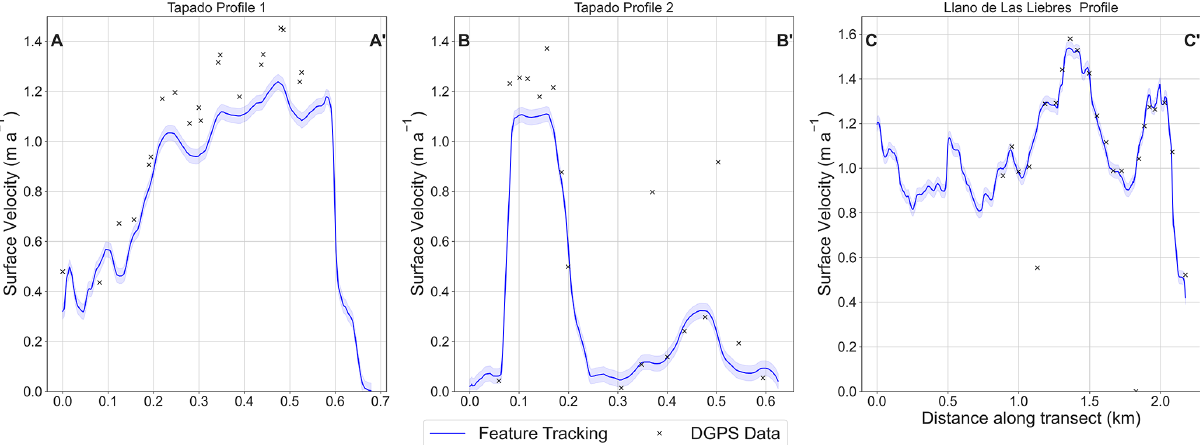
Figure 8. Comparison of optical-feature-tracking-based velocities and DGNSS-derived velocities along three profiles on the Tapado complex and Llano de Las Liebres. The locations of these transects are shown on Fig. 1. The blue shading represents the uncertainty of the feature tracking calculated based on the stable terrain.